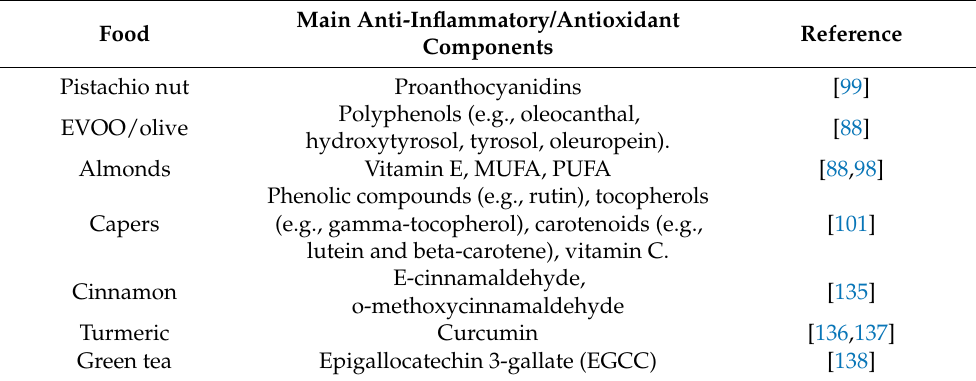
Table 1. Foods to be included in the nutritional suggestions and their nutraceutical compounds with anti ‐ inflammatory and antioxidant properties.